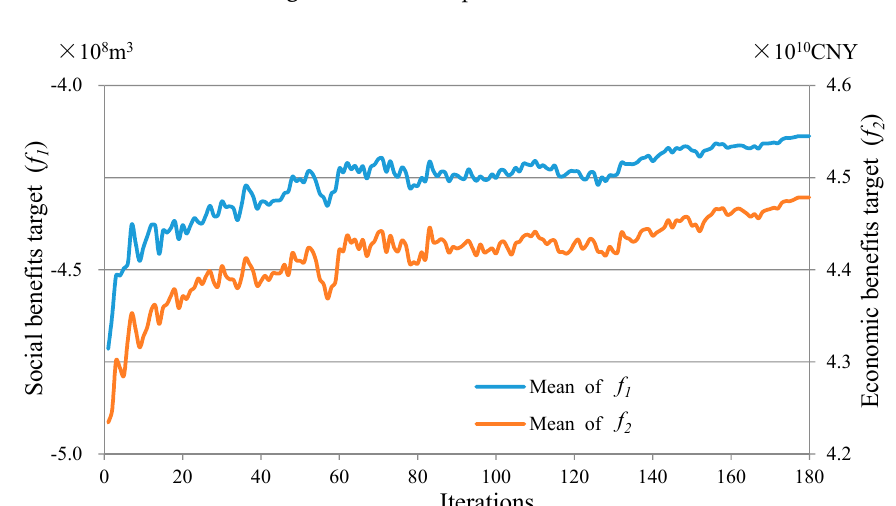
Figure 13. Iterative process of PSO.